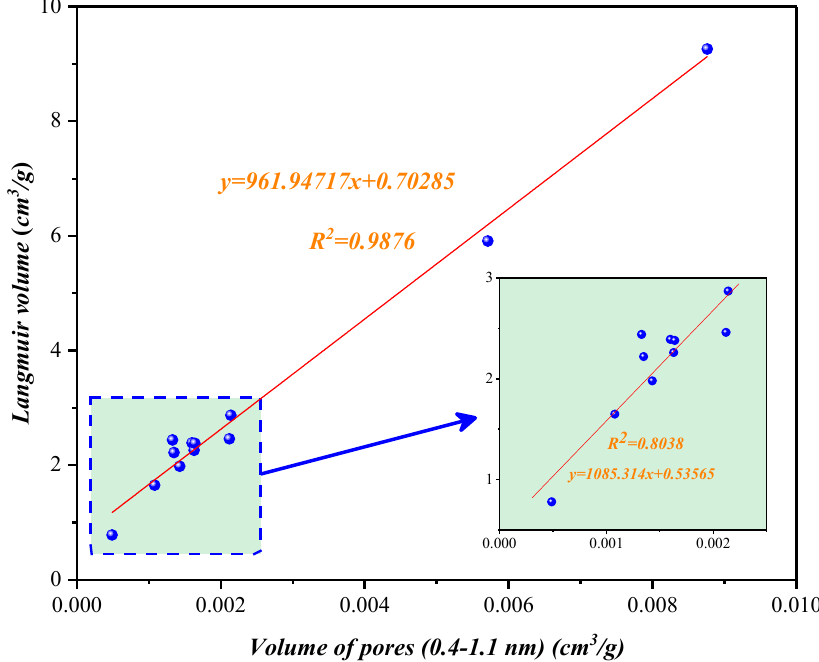
Figure 14. Relationship between methane adsorption capacity and pore volume (0.1–1.1 nm) for the 12 shale samples by the low-temperature carbon dioxide adsorption experiment.